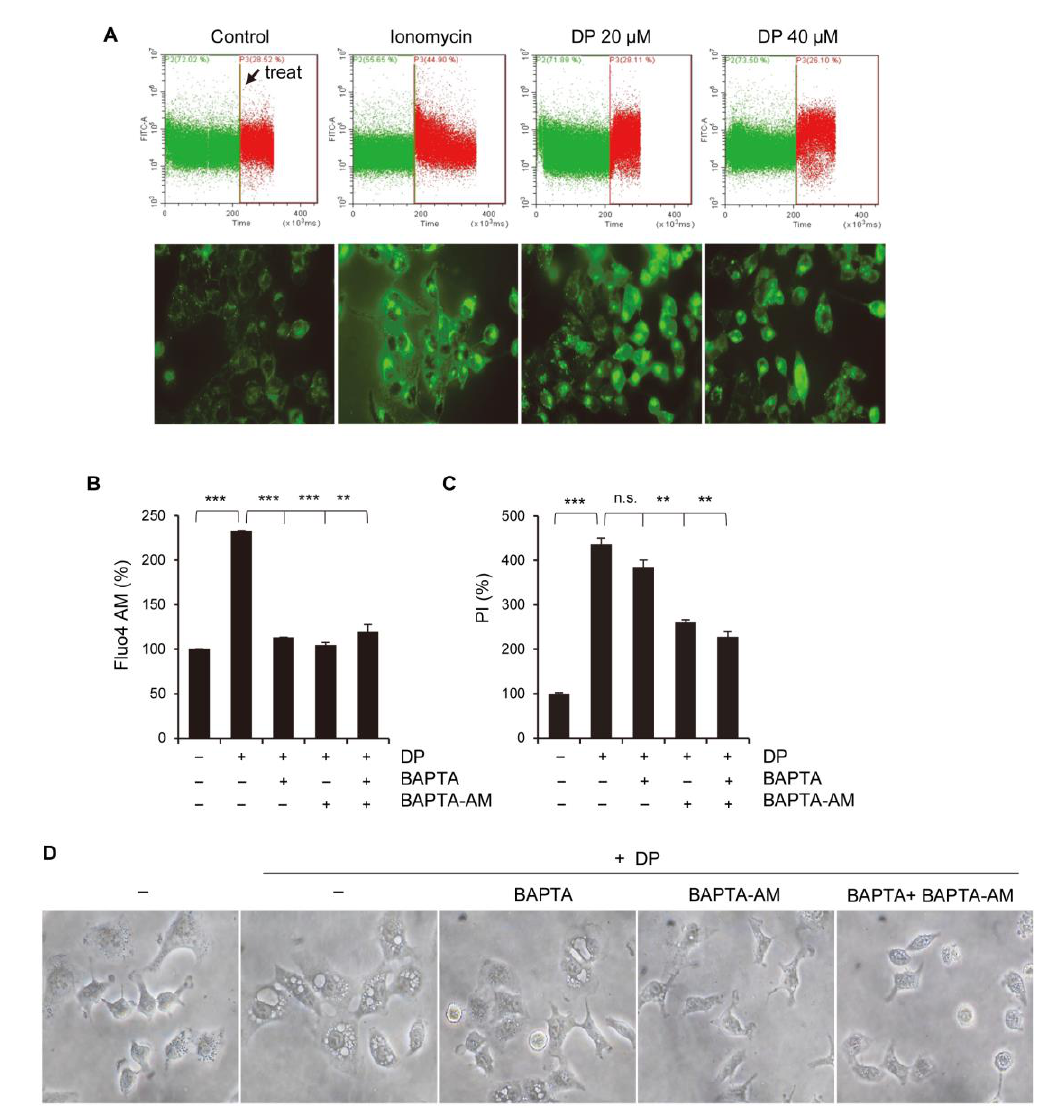
Figure 3. DP increases cytosolic Ca 2+ . ( A ) A549 cells were preloaded with 2 µg/mL Fluo-4 AM and incubated with 20 and 40 µM DP for 1 min to examine the changes in intracellular Ca 2+ using flow cytometry (upper panel) and a fluorescence microscope (lower panel). Ionomycin (1 µg/mL) was used as a positive control. ( B ) A549 cells were pretreated with 10 µM BAPTA, 10 µM BAPTA-AM, or 10 µM BAPTA plus 10 µM BPATA-AM, followed by treatment with 40 µM DP for 1 min. The cells were treated with 0.5 µg/mL Fluo-4 AM and analyzed using flow cytometry. ( C ) A549 cells were pretreated with Ca 2+ chelators, treated with 40 µM DP for 24 h, and the PI intensity was measured by flow cytometry. ( D ) A549 cells were pretreated with Ca 2+ chelators and further treated with 40 µM DP for 6 h. Cell morphological changes were observed under a microscope (magnification, × 200). All data are expressed as the mean ± SD obtained from at least three independent experiments. Statistical differences were analyzed by two-way ANOVA with Tukey’s multiple comparisons test and presented as p < 0.01 (**) and p < 0.001 (***) compared with the control. n.s.: not significant.